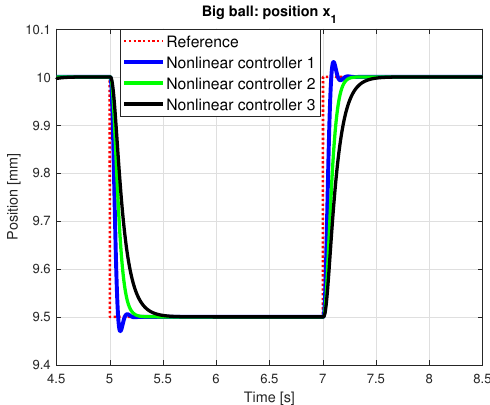
Figure 12. Small ball—control variable u : Simulation results for nonlinear control law, comparison of three variants of control parameters.